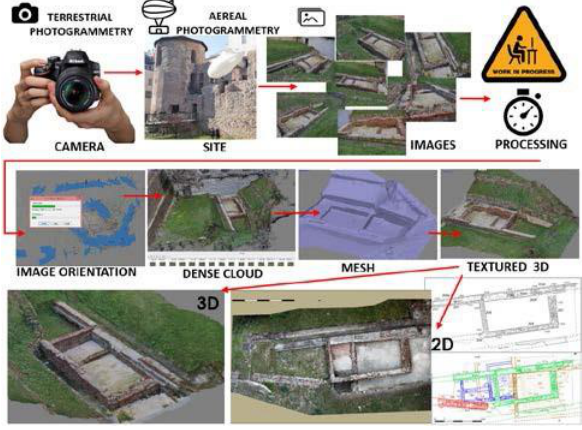
Figure 6 Workflow: from the photos obtained with digital photogrammetry to 3D models and 2D plans.